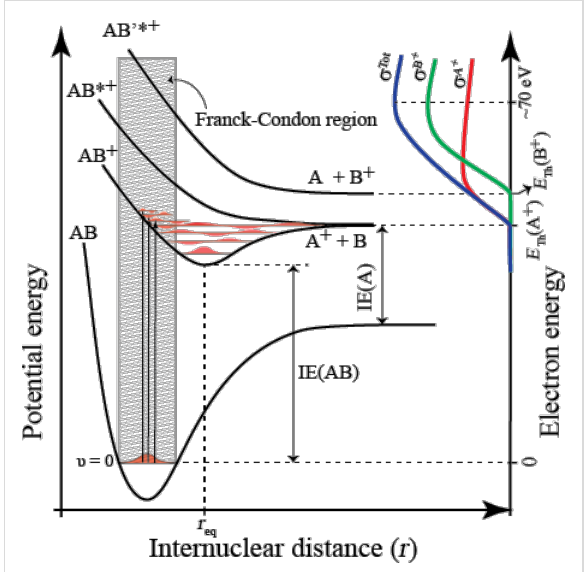
Figure 5: Simplified two-dimensional potential energy diagram for a quasi-diatomic dissociation through electron impact ionization (DI). The ionization process is depicted as a vertical transition from the neutral ground state to the cationic ground state and higher lying cationic states within the Franck–Condon region (shaded area). In this repre- sentation the cationic ground state has a considerably larger equilib- rium bond length ( r eq ) compared to the neutral, leading to a significant transition probability to vibrational states that are energetically above the dissociation limit. For simplification, the excited cationic states (AB + * and AB + ′ *) are shown to be purely repulsive. In this representa- tion the parent cation is formed as long as the electron incident energy is above the ionization energy of AB (IE(AB)) but below the dissocia- tion threshold leading to the formation of A + ( E Th (A + ). The higher-lying excited cationic state (AB + ′ *) is shown to lead to the formation of B + . The threshold for this channel is given by the sum of the ionization energy of B (IE(B)) and the bond dissociation energy of AB (BDE(AB)). On the right-hand y -axis, the energy dependence of the relative cross section for the formation of A + and B + ( σ A+ and σ B+ ) are shown as red and green lines and the total DI cross section ( σ Tot ) is shown with a solid line as the sum of the two partial cross sections. The threshold energy ( E Th ) for the formation of the fragments A + and B + are indi- cated on the right-hand y -axis and the maximum total DI cross section is shown to be at 70 eV. In the case of a polyatomic molecule, the situ- ation is considerably more complex and intramolecular energy re-distri- bution, multiple fragmentations and rearrangement reactions may dominate the ion formation at higher